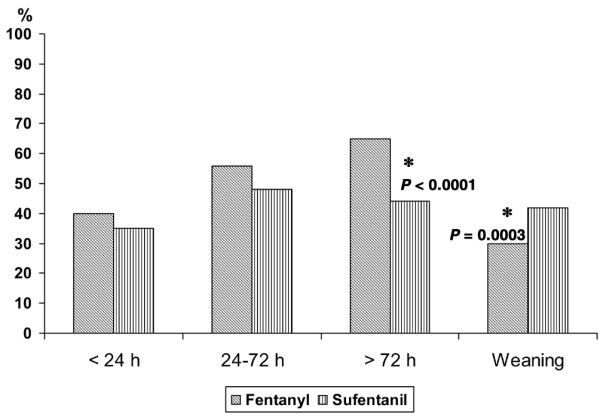
The most commonly used analgesic agents during the different sedation periods. *Differences between fentanyl and sufentanil in a phase (χ2 test, P < 0.05). The values were tested with the χ2 test (P < 0.05) and multiple differences with the Bonferroni–Holm multiple test procedure. (Fentanyl: less than 24 hours versus 24–72 hours versus more than 72 hours versus weaning, all P < 0.01. Sufentanil: less than 24 hours versus 24–72 hours; less than 24 hours versus more than 72 hours; 24–72 hours versus more than 72 hours and 24–72 hours versus weaning, all P = 0.01; less than 24 hours versus weaning, P = 0.04; more than 72 hours versus weaning, P = 0.55.)